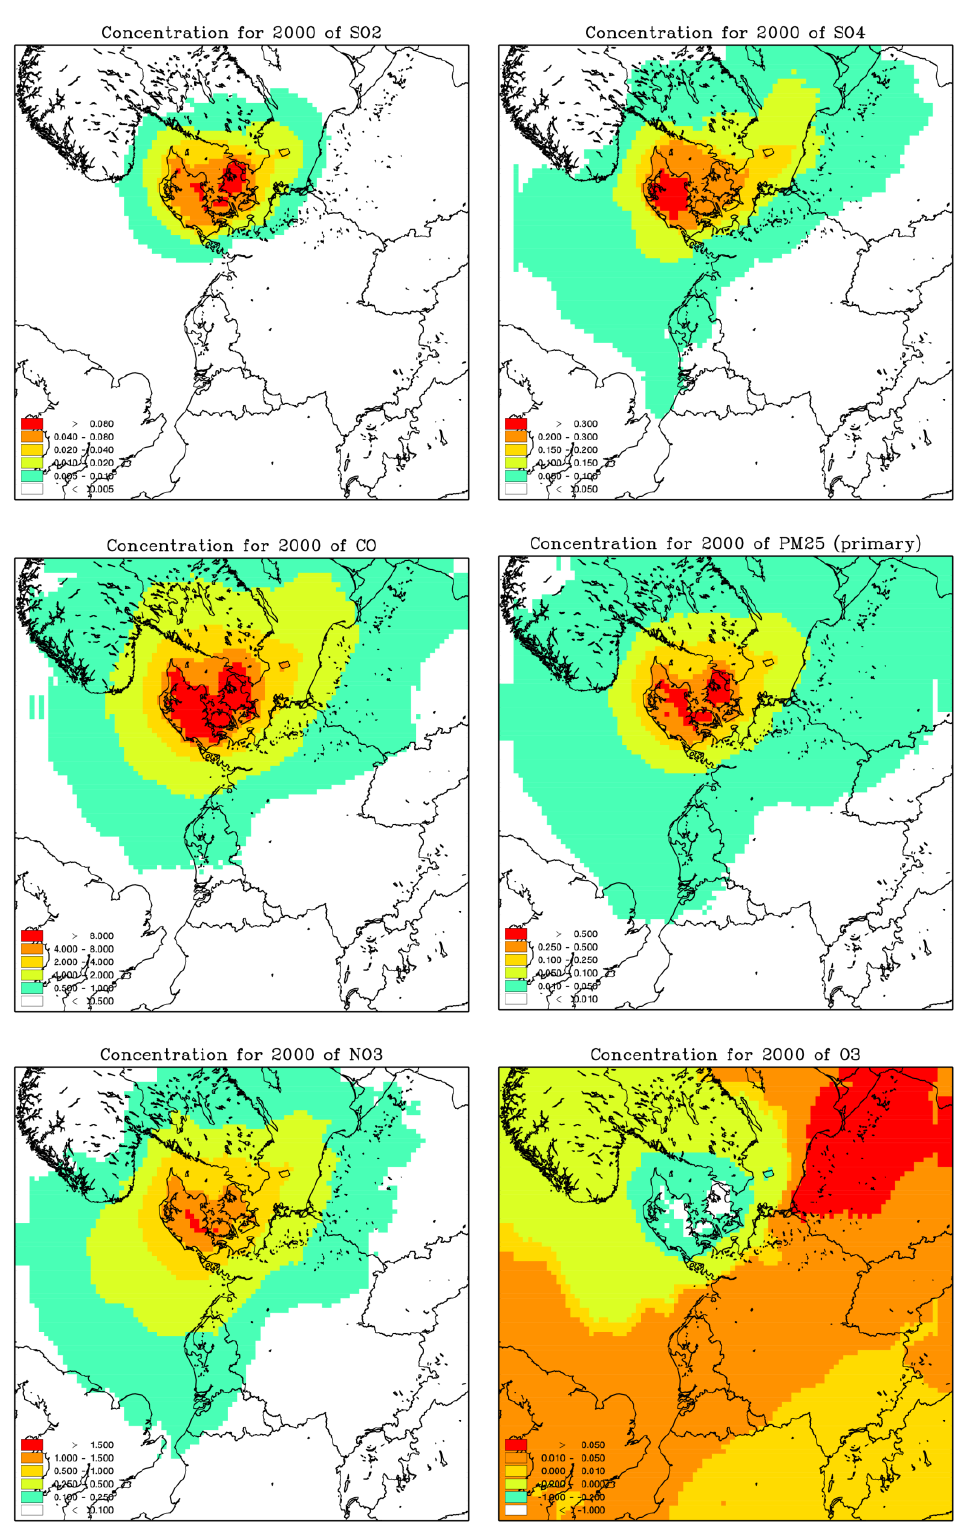
Fig. 4. Contribution to the mean annual air pollution levels ( δ -concentrations) calculated using the DEHM model due to emissions from the whole of Denmark for all SNAP categories 1 to 10 simultaneously, for the year 2000. The compounds are SO 2 [ppb], SO 2 − [ppm], PM 2 . 5 (primary part) [µgm − 3 ], NO − [µgm − 3 ] and O 3 [ppb]. Results are shown for DEHM domain number 3